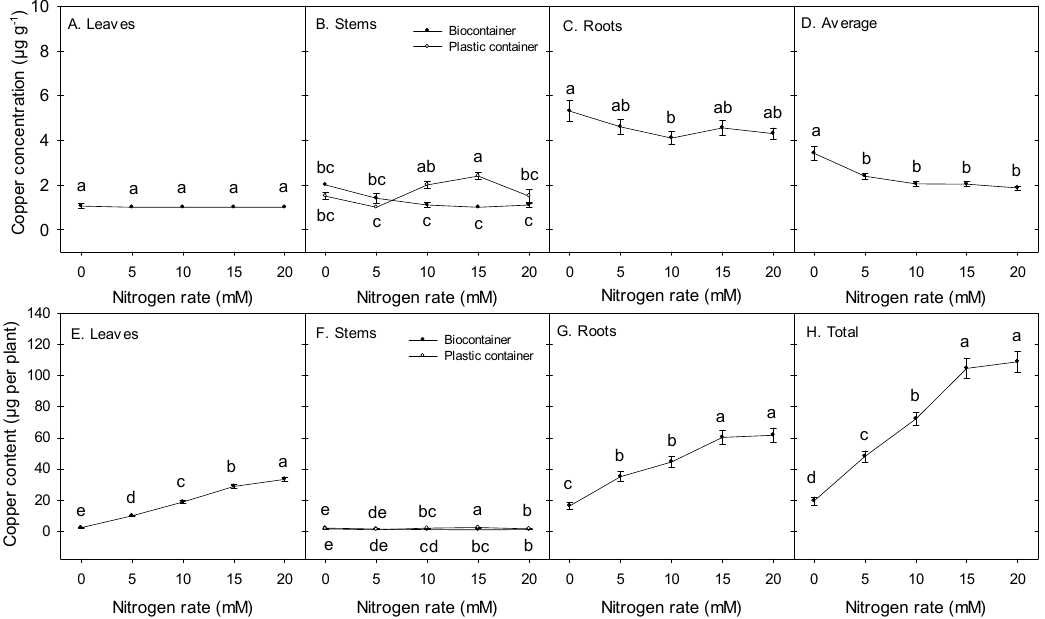
(Table 1). Irrigation frequency did not a ff ect Fe concentration or content in any structure type or in the entire plant.